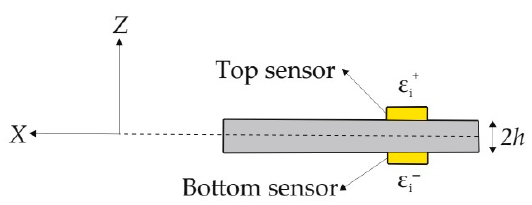
Figure 2. Experimental strain data collected from the top and bottom surfaces of a plate structure.